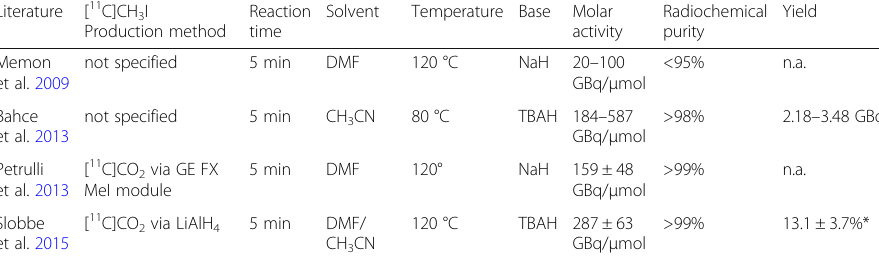
Table 2 Comparison of synthesis procedures described in literature Literature [ 11 C]CH 3 I Reaction Production method